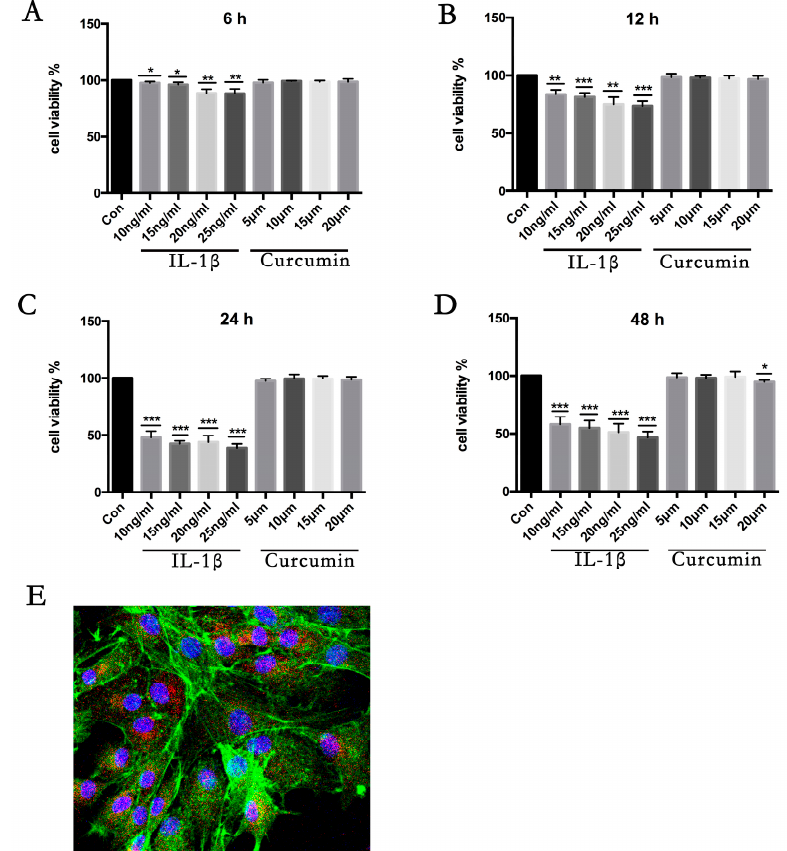
Figure 2. Effects of curcumin and interleukin 1 β (IL-1 β ) on the viability and proliferation of primary chondrocytes in vitro. To evaluate the effect of curcumin or IL-1 β -induced cytotoxicity, primary chondrocytes were treated with 10 ng/mL, 15 ng/mL, 20 ng/mL, and 25 ng/mL IL-1 β or 5 µ